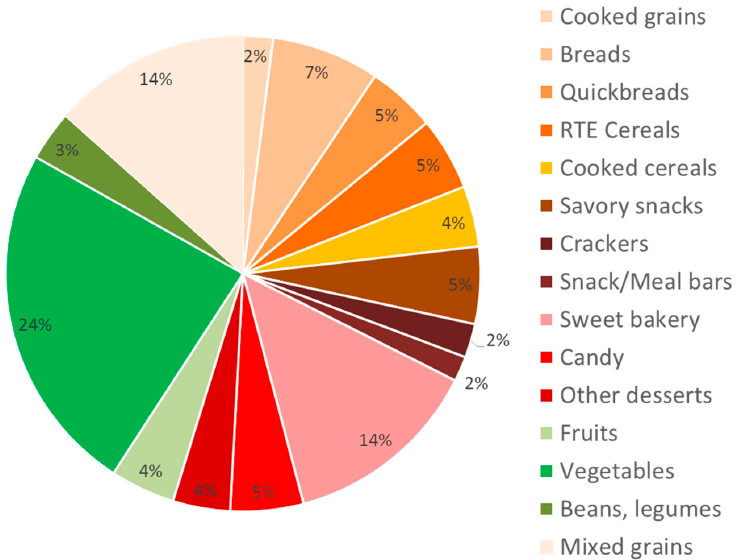
Figure 1. Distribution of Carbohydrate Foods in the Food and Nutrient Database for Dietary Studies (FNDDS) ( N = 2596). Table 3. Number and Percentage of “Higher-Quality Carbohydrate Foods” Based on Single Component and Composite Scoring